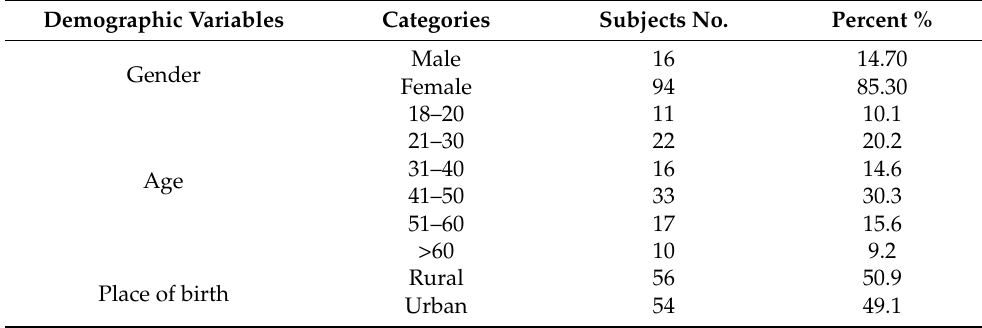
Table 1. Distribution of respondents by age. Demographic